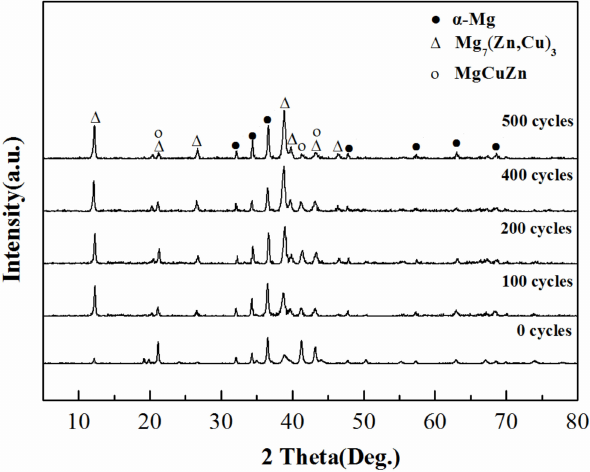
Figure 1. XRD spectrum of as-cast Mg-25%Cu-15%Zn alloy after different thermal cycles.